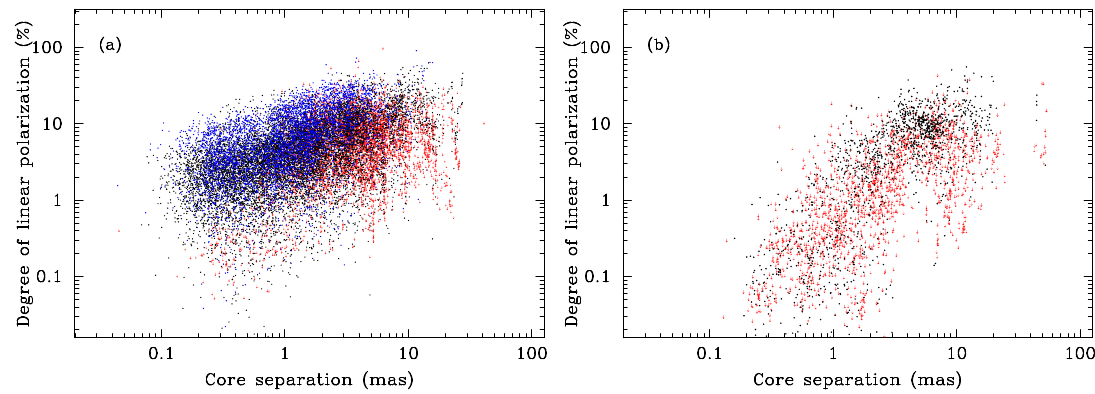
Figure 1. ( a ) Fractional polarization at positions of components in total intensity with distance from the 15 GHz core for quasars (black) and BL Lacertae objects (blue). Dots show measurements, while red arrows represent upper limits. ( b ) Same for radio galaxies.